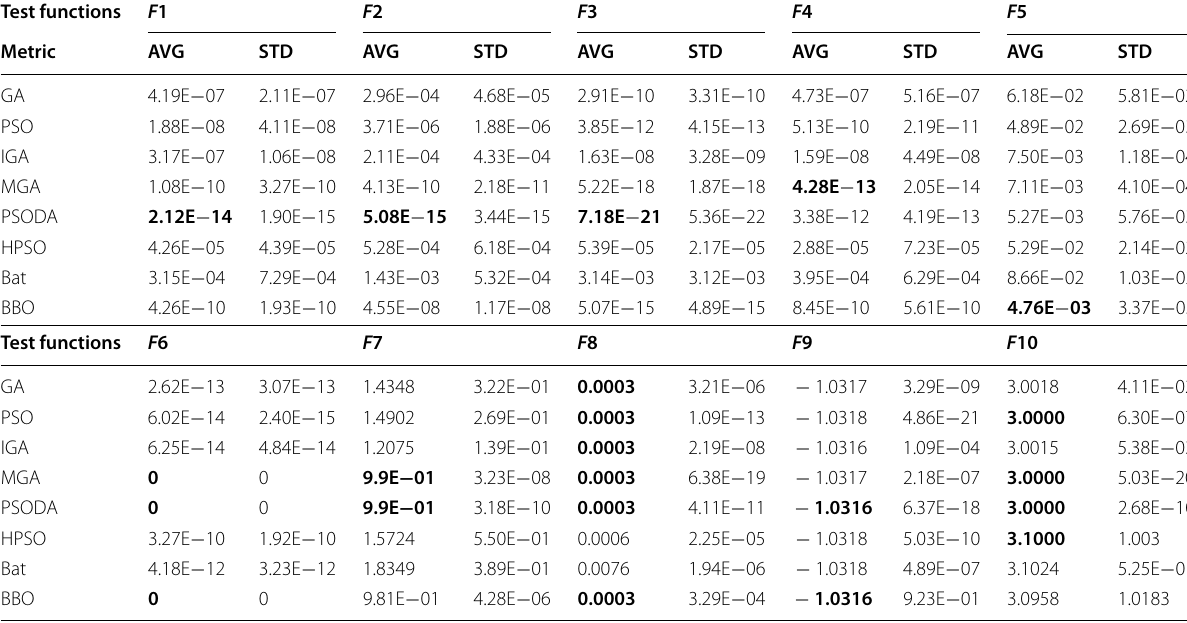
Bold values in the table are related to the maximum or minimum of the obtained results